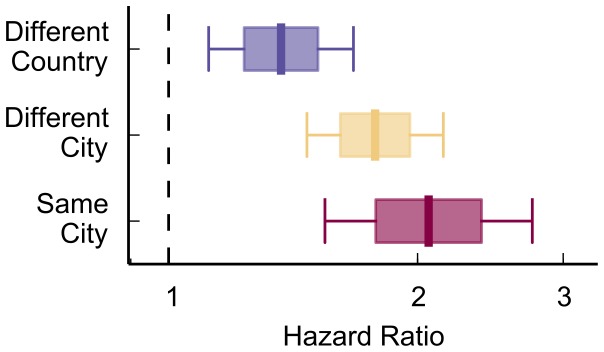
Geographically closer relationships had faster mobilization speed.Social mobilization was faster when the recruiter and recruit are in the same city, and slowest when they were in different countries.